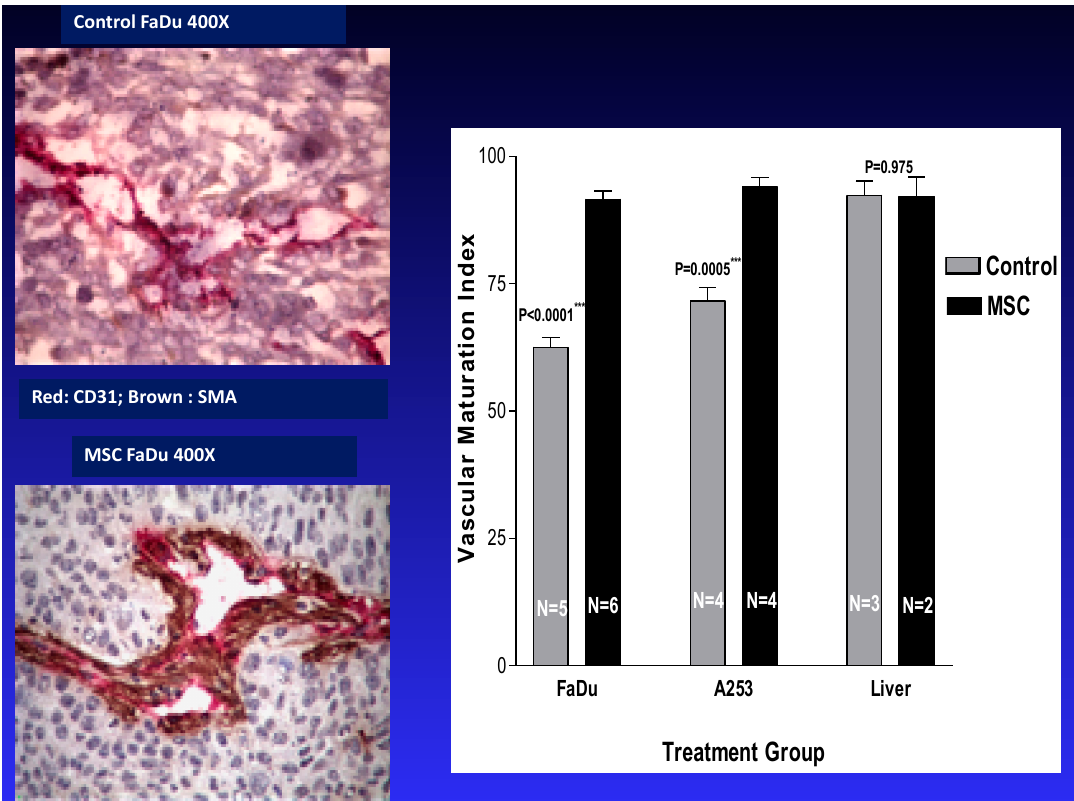
Figure 3. MSC selectively stabilizes tumor vasculature [68,70]. Effects of MSC treatment on the stabilization of tumor vasculature. Xenografts bearing FaDU tumors were treated orally with 10 mg/kg MSC daily for seven days, at which point the vascular maturation in tumor and normal liver tissues was assessed histologically [68,70].